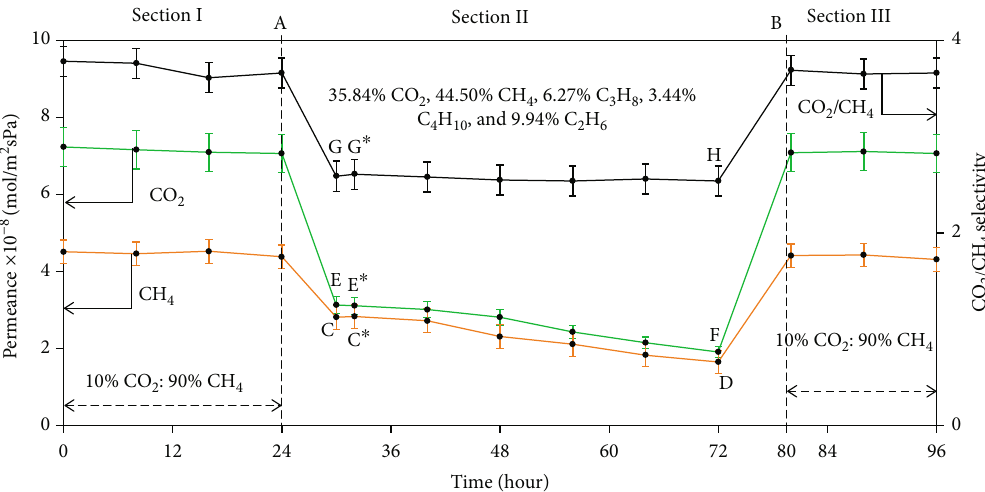
Figure 4: E ff ect of hydrocarbon impurities on the performance of DDR3 membrane and its durability test (separation results points C, E, and G were determined at a temperature of 30.1 ° C, feed pressure of 1 bar, with the CO